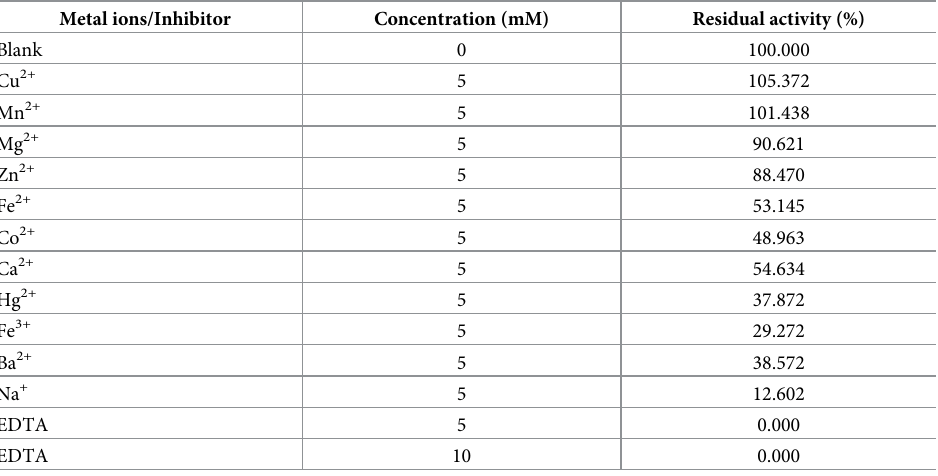
Table 3. Effect of metallic ions and elastase inhibitors.